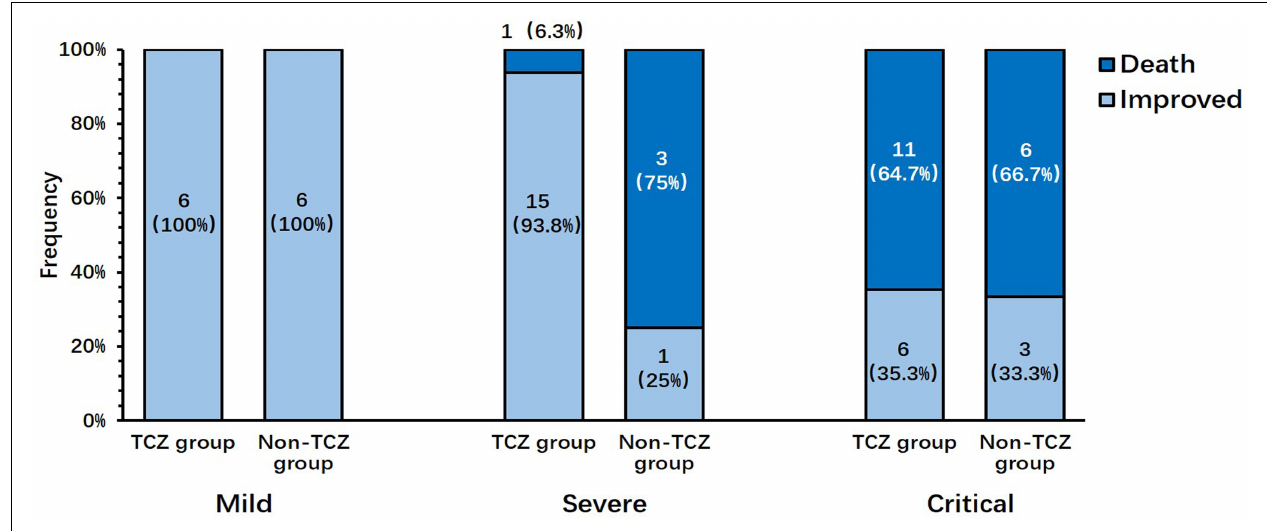
FIGURE 1 | Distribution of disease severity in patients who improved or died after treatment with or without tocilizumab.